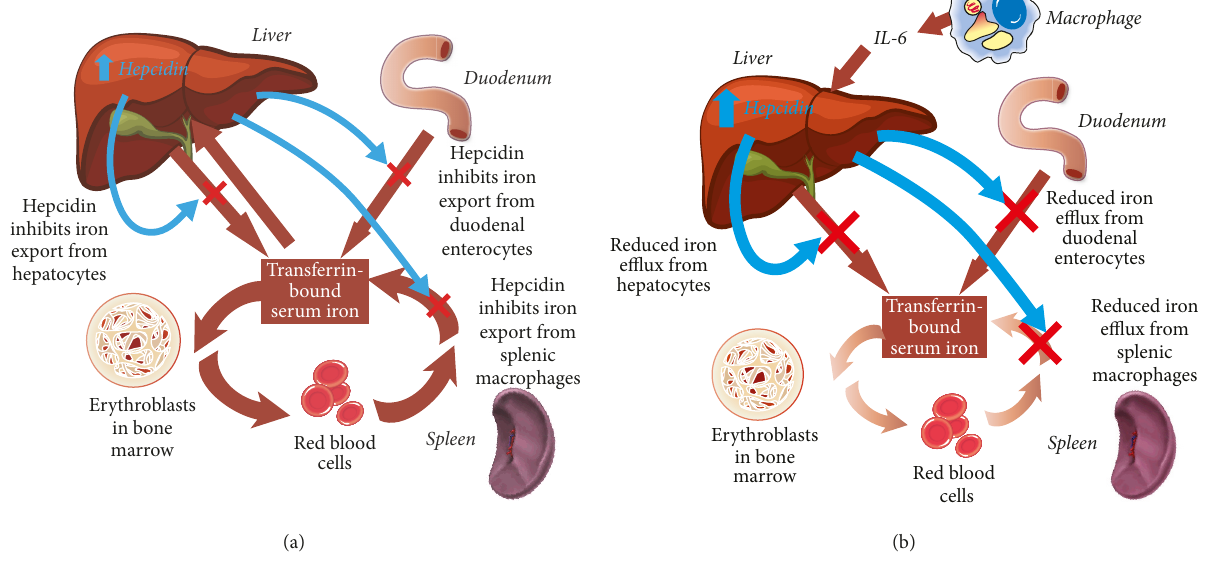
Figure2:Theroleofhepcidininsystemicironhomeostasis.(a)Inhealthyindividuals,hepcidinproductionincreasesinresponsetoincreasing levels of transferrin-bound serum iron and iron stores. Hepcidin internalizes and degrades the iron transporter ferroportin, restricting the export of iron from enterocytes and from iron stores in hepatocytes and macrophages, to restore normal iron levels. (b) In inflammatory conditions, hepcidin production increases in response to inflammatory cytokines such as IL-6, disrupting the usual homeostatic mechanisms. Ferroportin is internalized and degraded, reducing transmembrane export of iron, and the availability of iron to bind to transferrin is